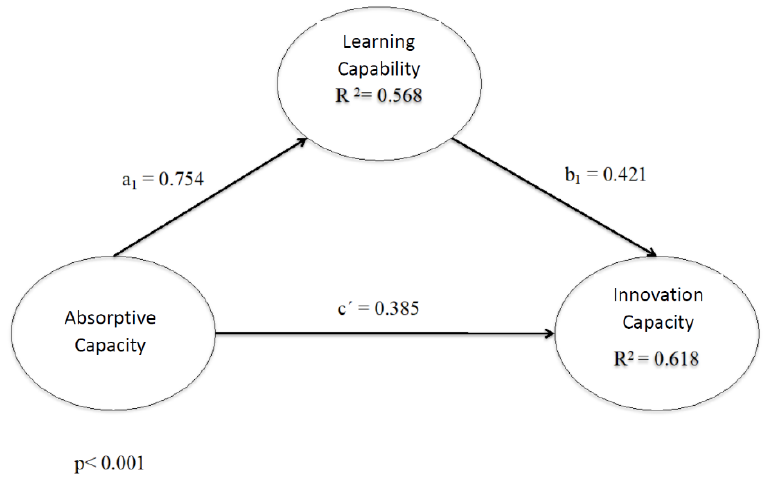
Figure 3. Mediation